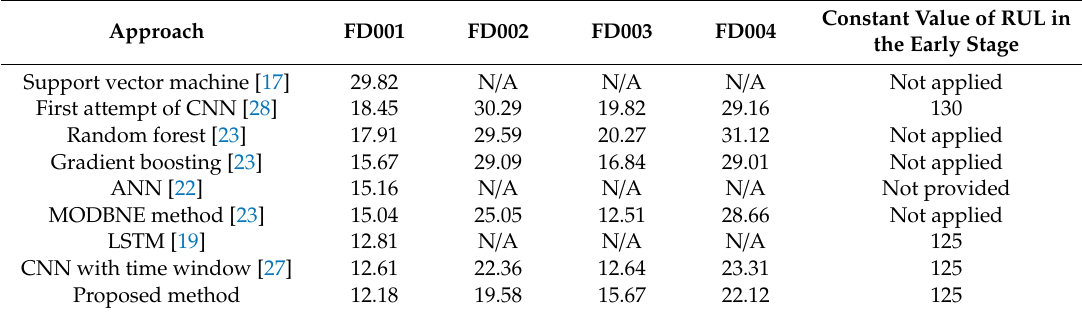
Table 7. Performance of various methods on the C-MAPSS dataset